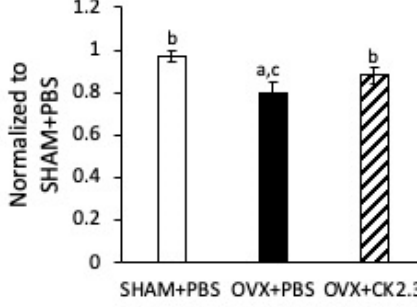
Figure 4. CK2.3 improved femoral shaft stiffness of OVX rats. Both left and right femurs were subjected to 3-point bending test. CK2.3-injected OVX rats’ femur had significantly higher stiffness than PBS-injected OVX rats. (a) Indicated a significant difference over SHAM, (b) indicated a significant difference over OVX+PBS, and (c) indicated a significant difference over OVX+CK2.3.